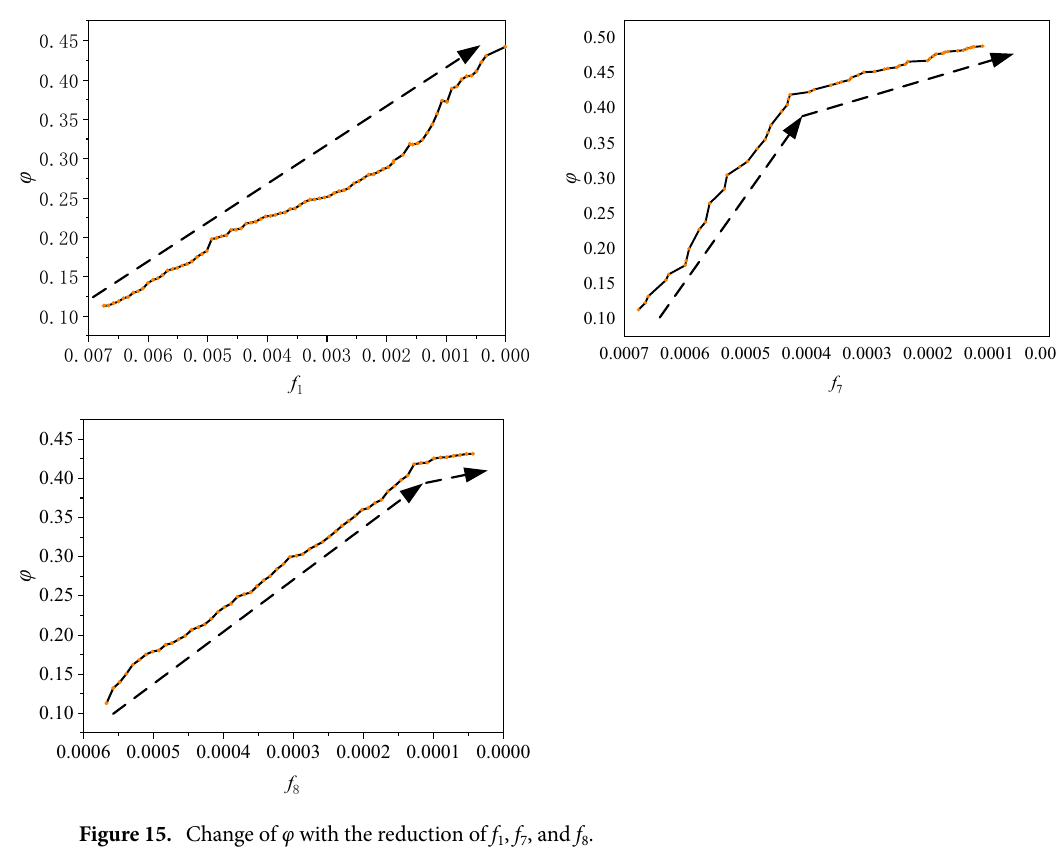
Figure 15. Change of φ with the reduction of f 1 , f 7 , and f 8 .